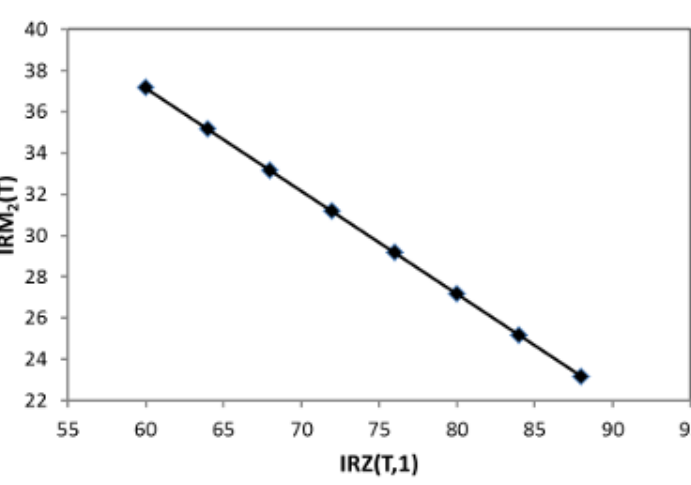
Figure 4: Relation between irregularity indices IRZ ( G, 1) and IRM different results with IRZ ( G, 1) and IRM